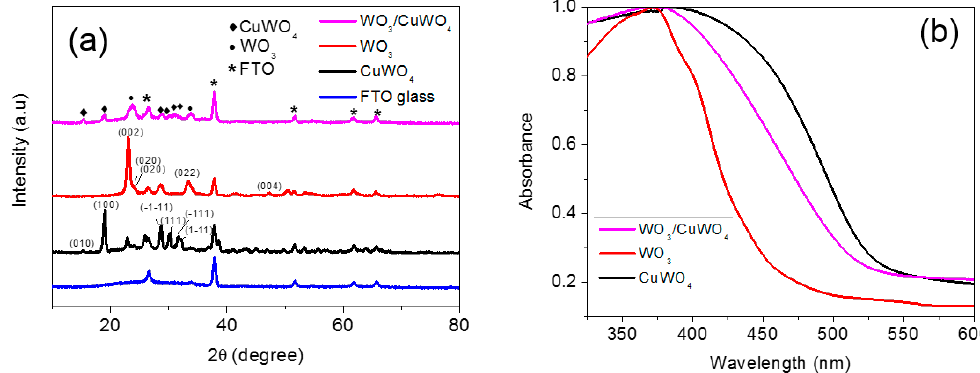
Figure 1. XRD patterns ( a ) and UV-Vis absorption spectrum ( b ) of pristine WO 3 , WO 3 /CuWO 4 , and CuWO 4 thin films.